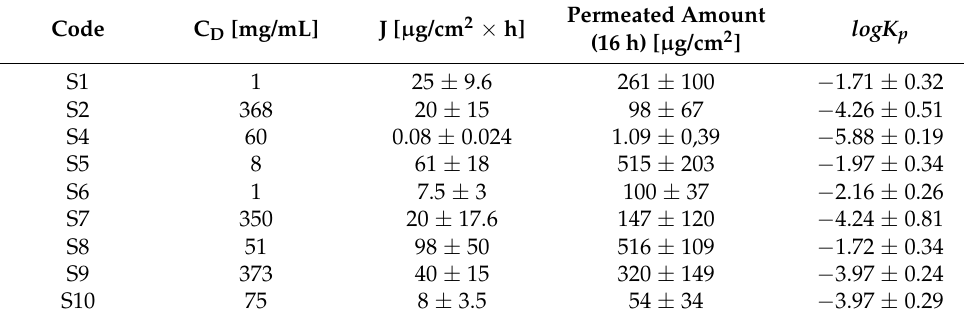
Table 4. Characteristic parameters of permeability of PER across pig ear skin in different